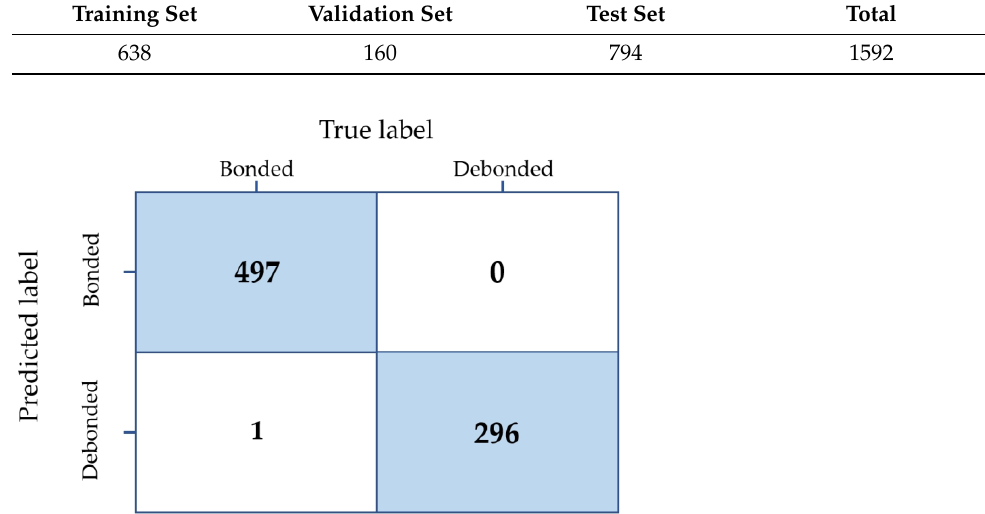
Table 6. The dimension of the training, validation, and test set of DNN.